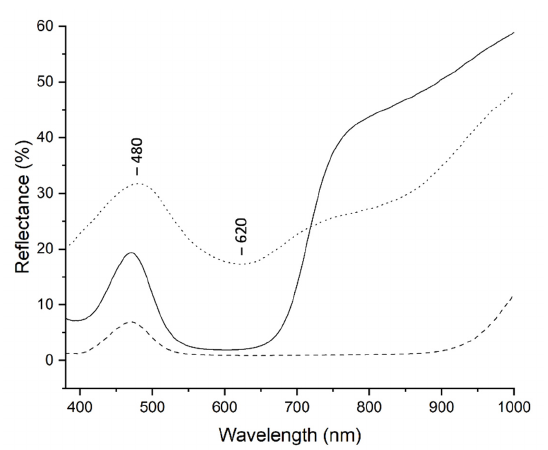
Figure 4. FORS spectra of azurite (dashed line) in point 2 of 18r, ultramarine (solid line) in point 3 of 8r, and ultramarine combined with azurite and lead white (dotted line) in point 5 of 8r.